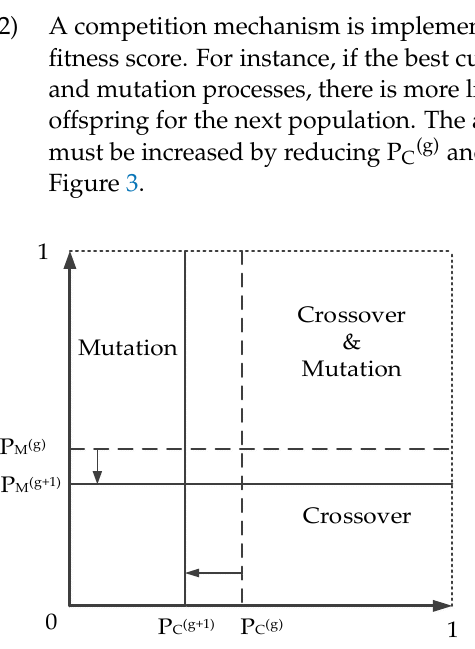
Figure 3. Figure 3.